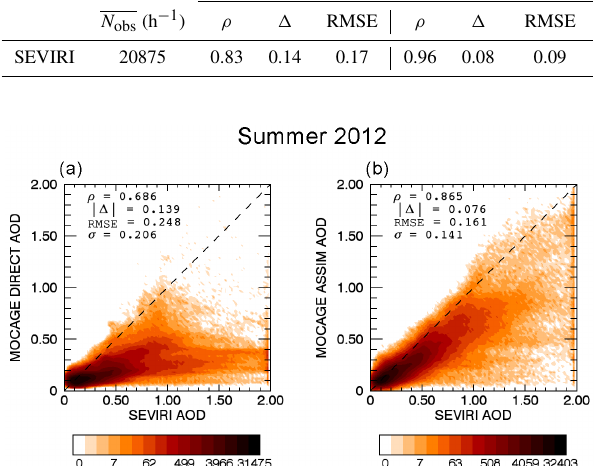
Table 2. Correlation ( ρ ), absolute bias ( (cid:49) ) and root mean square error (RMSE) between SEVIRI observations and MOCAGE di- rect/assimilation model run for the western Mediterranean during the TRAQA campaign between 25 June and 13 July 2012. The mean number of SEVIRI observations per hour is also given. The statistics correspond to Fig. 3 with the observations localized in the region 0– 10 ◦ E, 35–45 ◦ N (marked in Fig. 5 by the grey box). MOCAGE direct